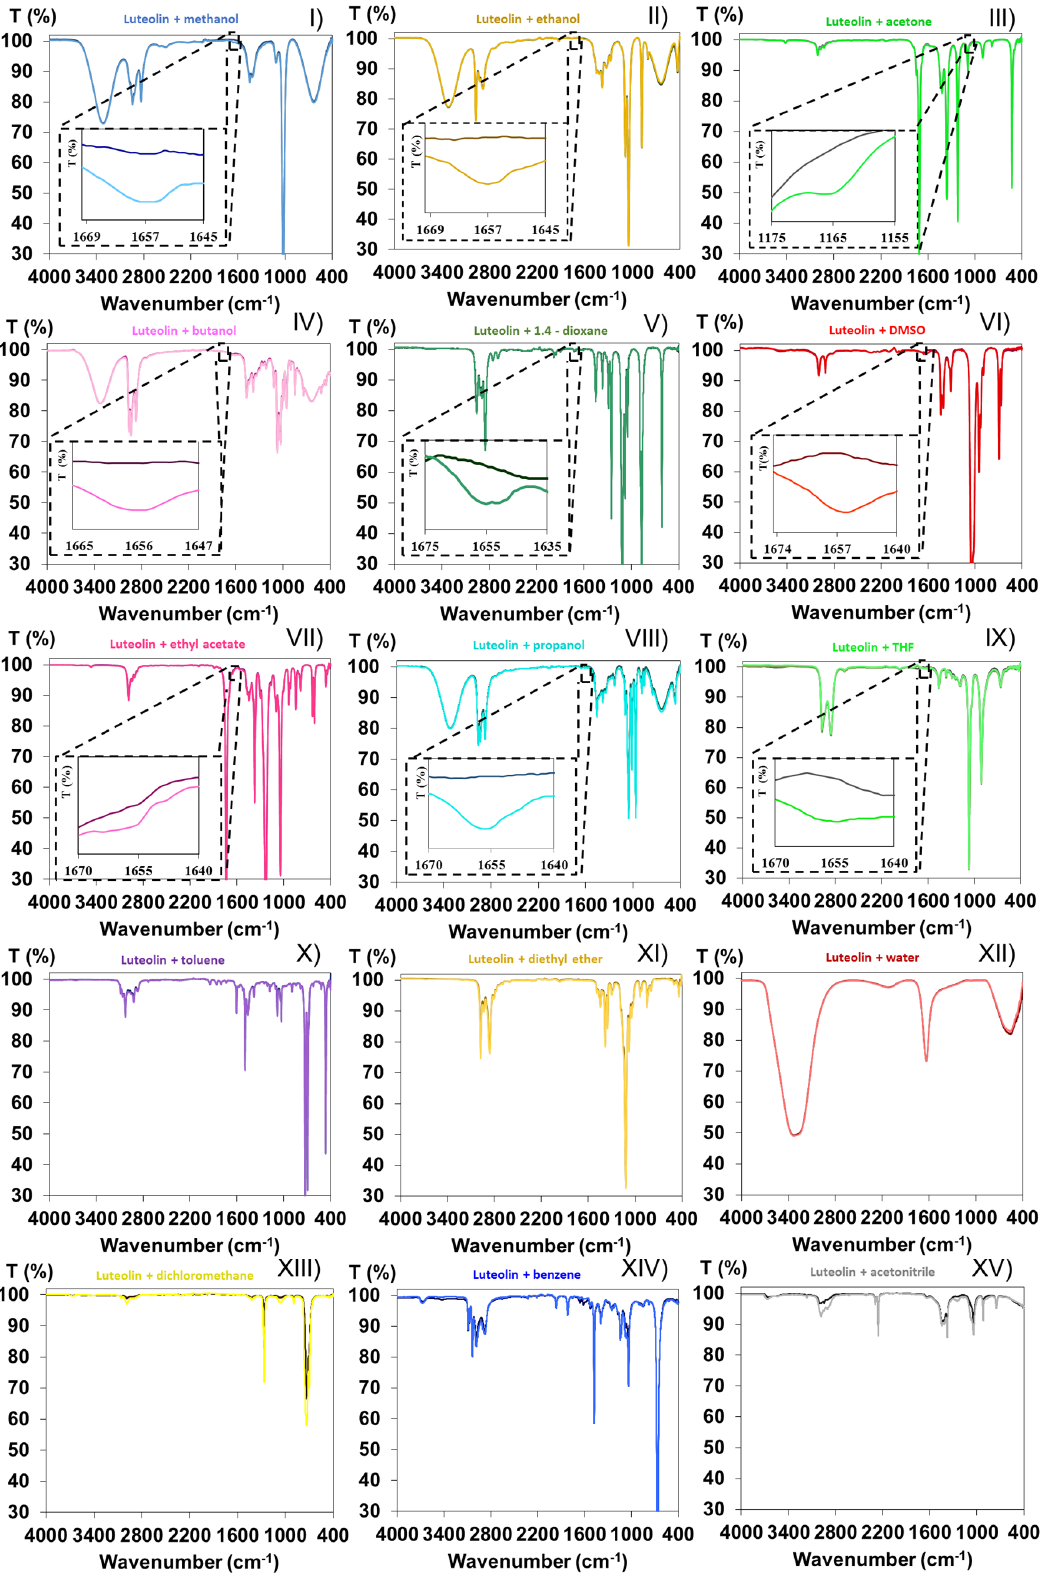
Figure 2. FTIR–ATR spectra of luteolin dissolved in various solvents. Spectrum of pure solvent is presented with darker color, while the spectrum of luteolin dissolved in the respective solvent has a lighter color: ( I ) methanol, ( II ) ethanol, ( III ) acetone, ( IV ) butanol, ( V ) 1,4-dioxane, ( VI ) DMSO, ( VII ) ethyl acetate, ( VIII ) propanol, ( IX ) THF, ( X ) toluene, ( XI ) diethyl ether, ( XII ) water, ( XIII ) dichloromethane, ( XIV ) benzene and ( XV )